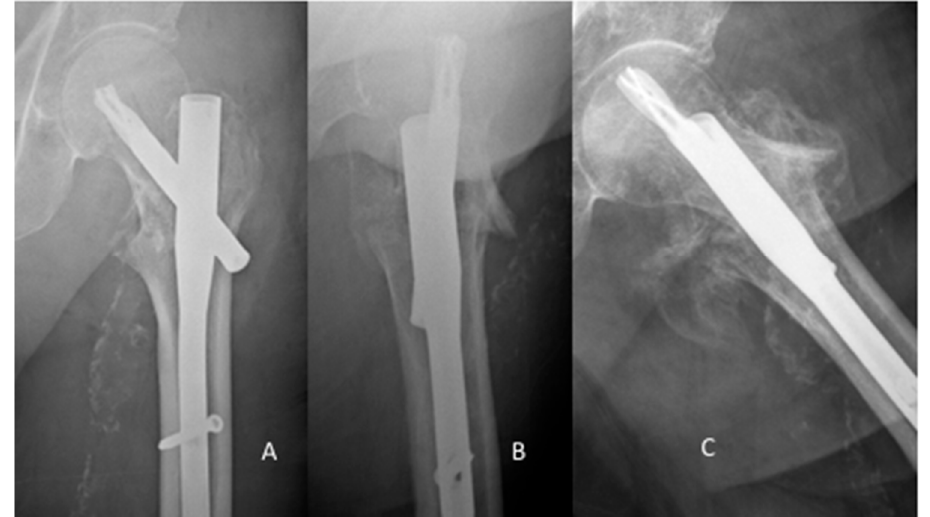
Figure 4. Cut-out Proximal Femur Nail Antirotation (PFNA) . PFNA AP view and lateral view post surgery ( A , B ), imminent cut-out in lateral view six weeks post-surgery ( C ).